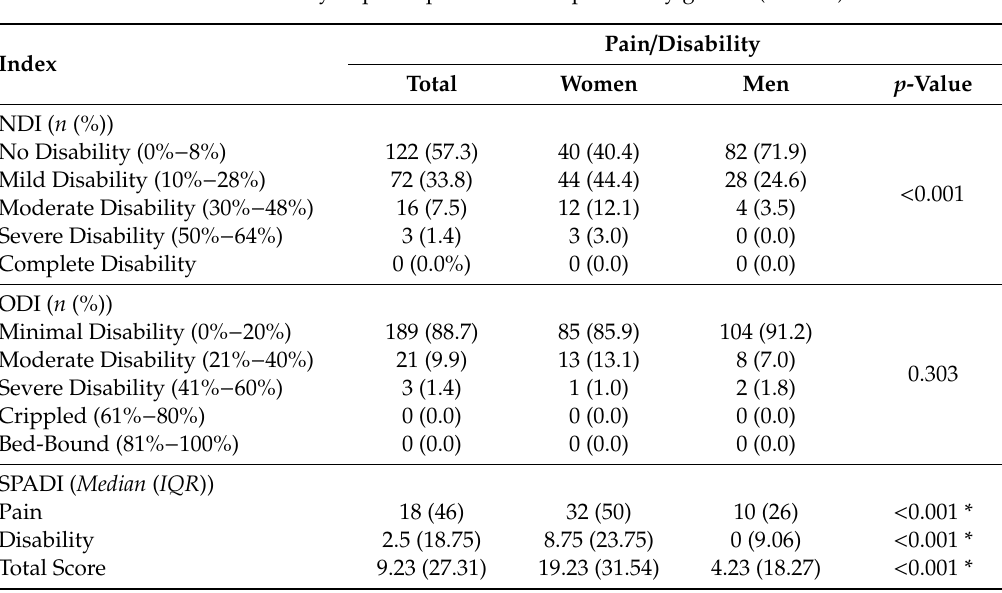
Table 5. Disability of participants and comparison by gender ( n =